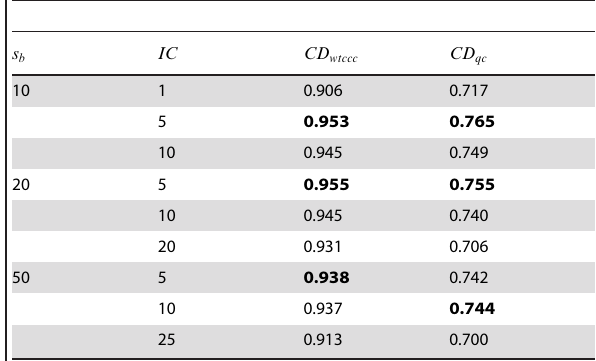
Table 2. T-Trees: block map and internal complexity